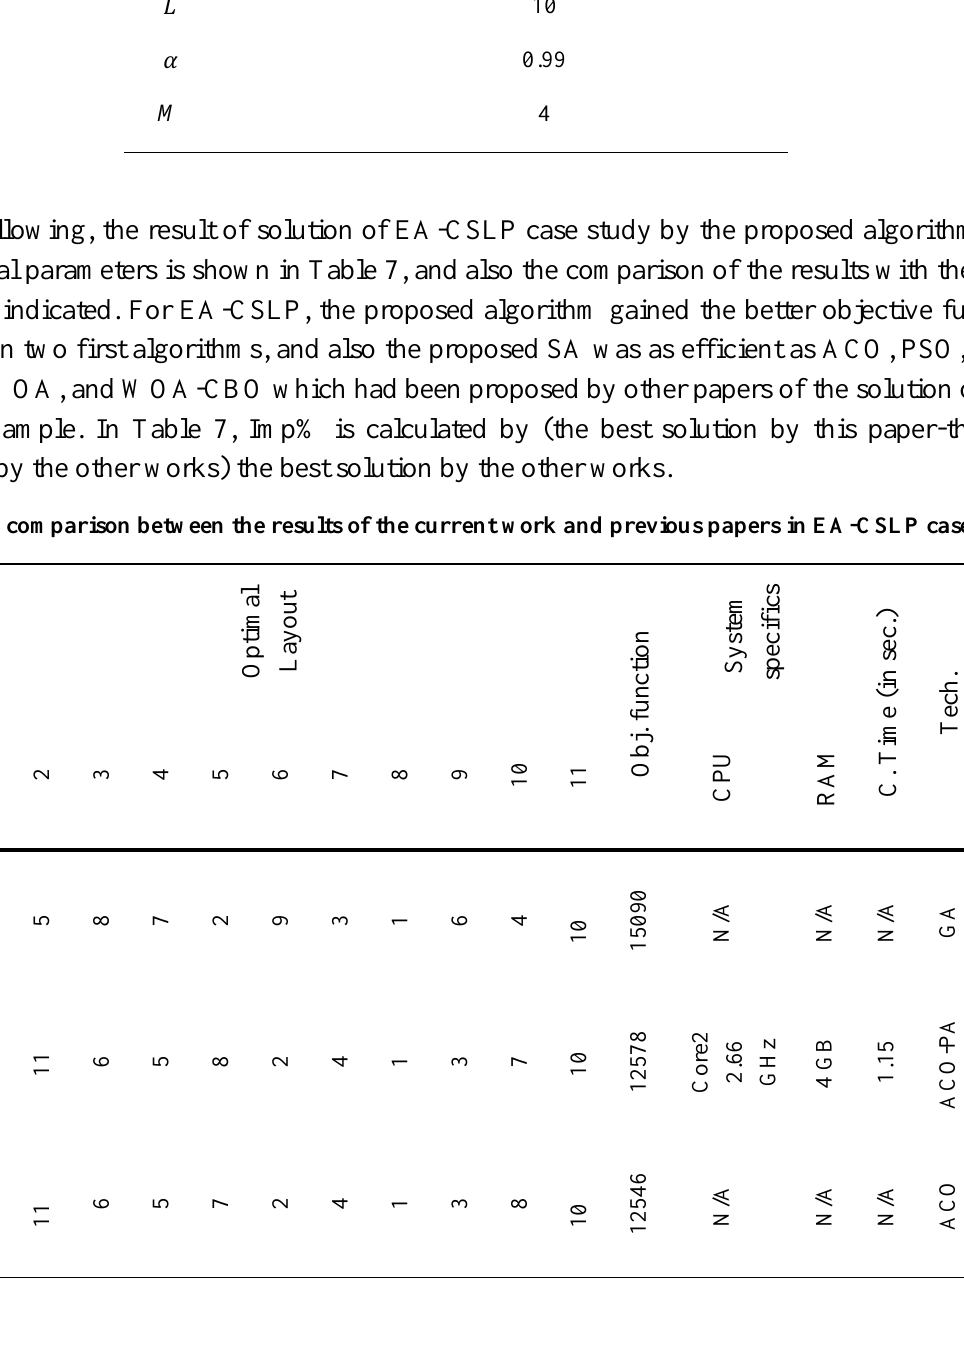
Table 6. Optimal values for minimization of the computational time of EA-CSLP case study.